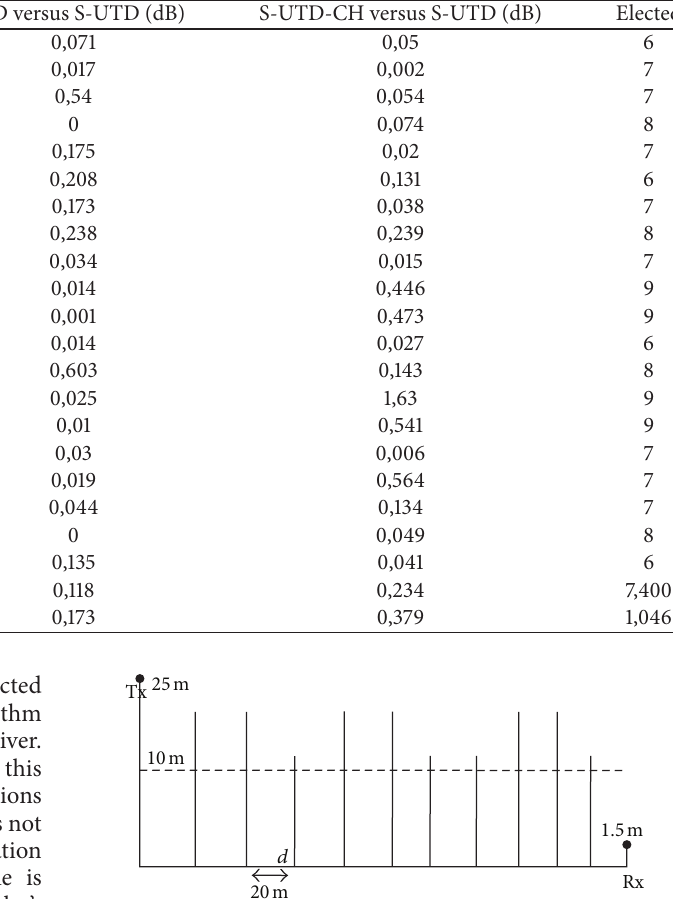
Table 1: Comparison results of highly elevated receiver height (25m).